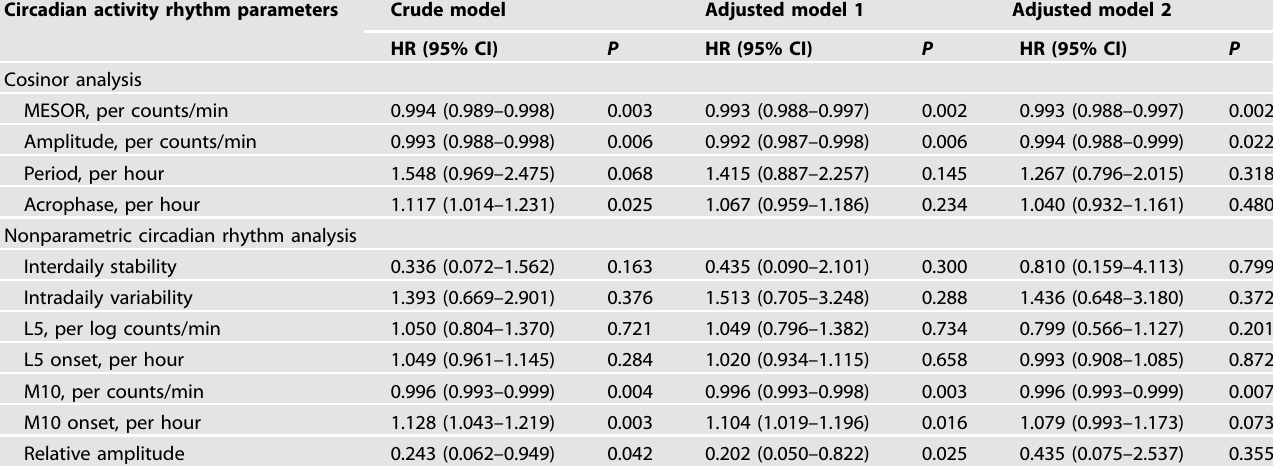
Table 2. Cox proportional hazards analysis for mood episode relapse associated with circadian activity rhythm